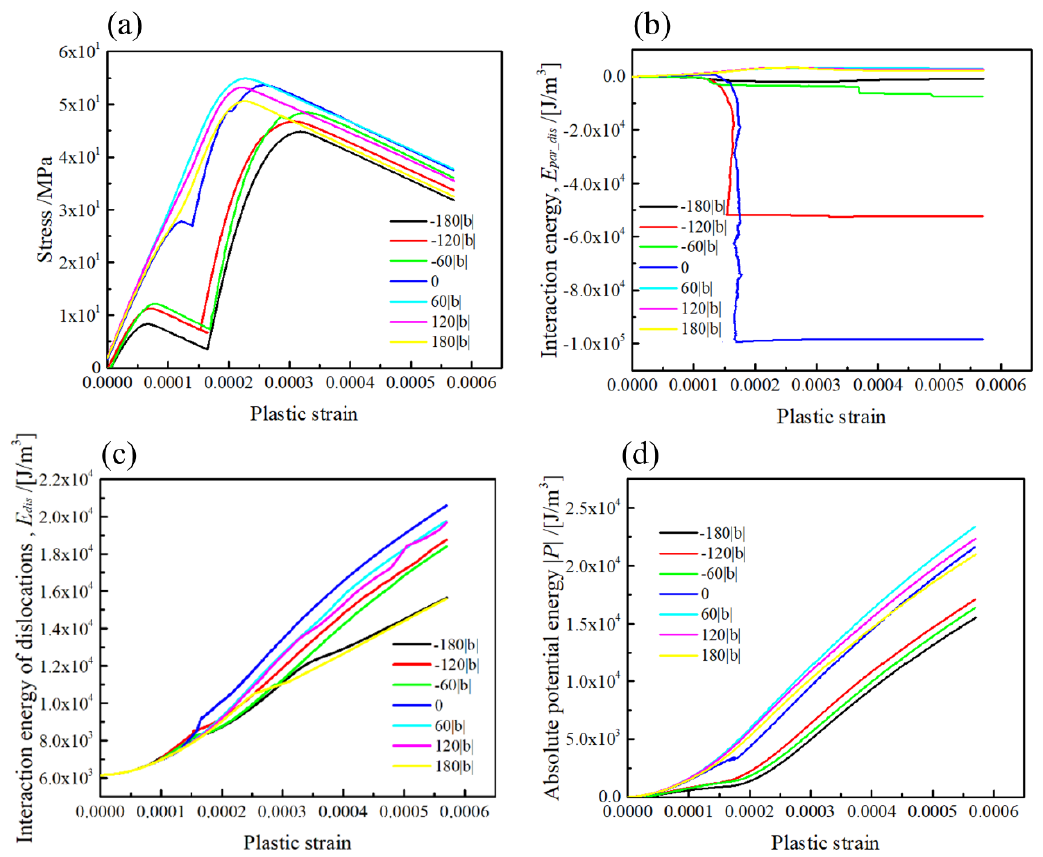
Figure 7. The geometrical effect on the misfit hardening by the [100] rod precipitate. ( a ) Stress–strain curve, ( b ) interaction energy of the precipitate and dislocation, ( c ) interaction energy of the dislocations and ( d ) potential energy due to the dislocation motion The relative position of the (111) slip plane is ranging from z/|b| = −180 to 180.